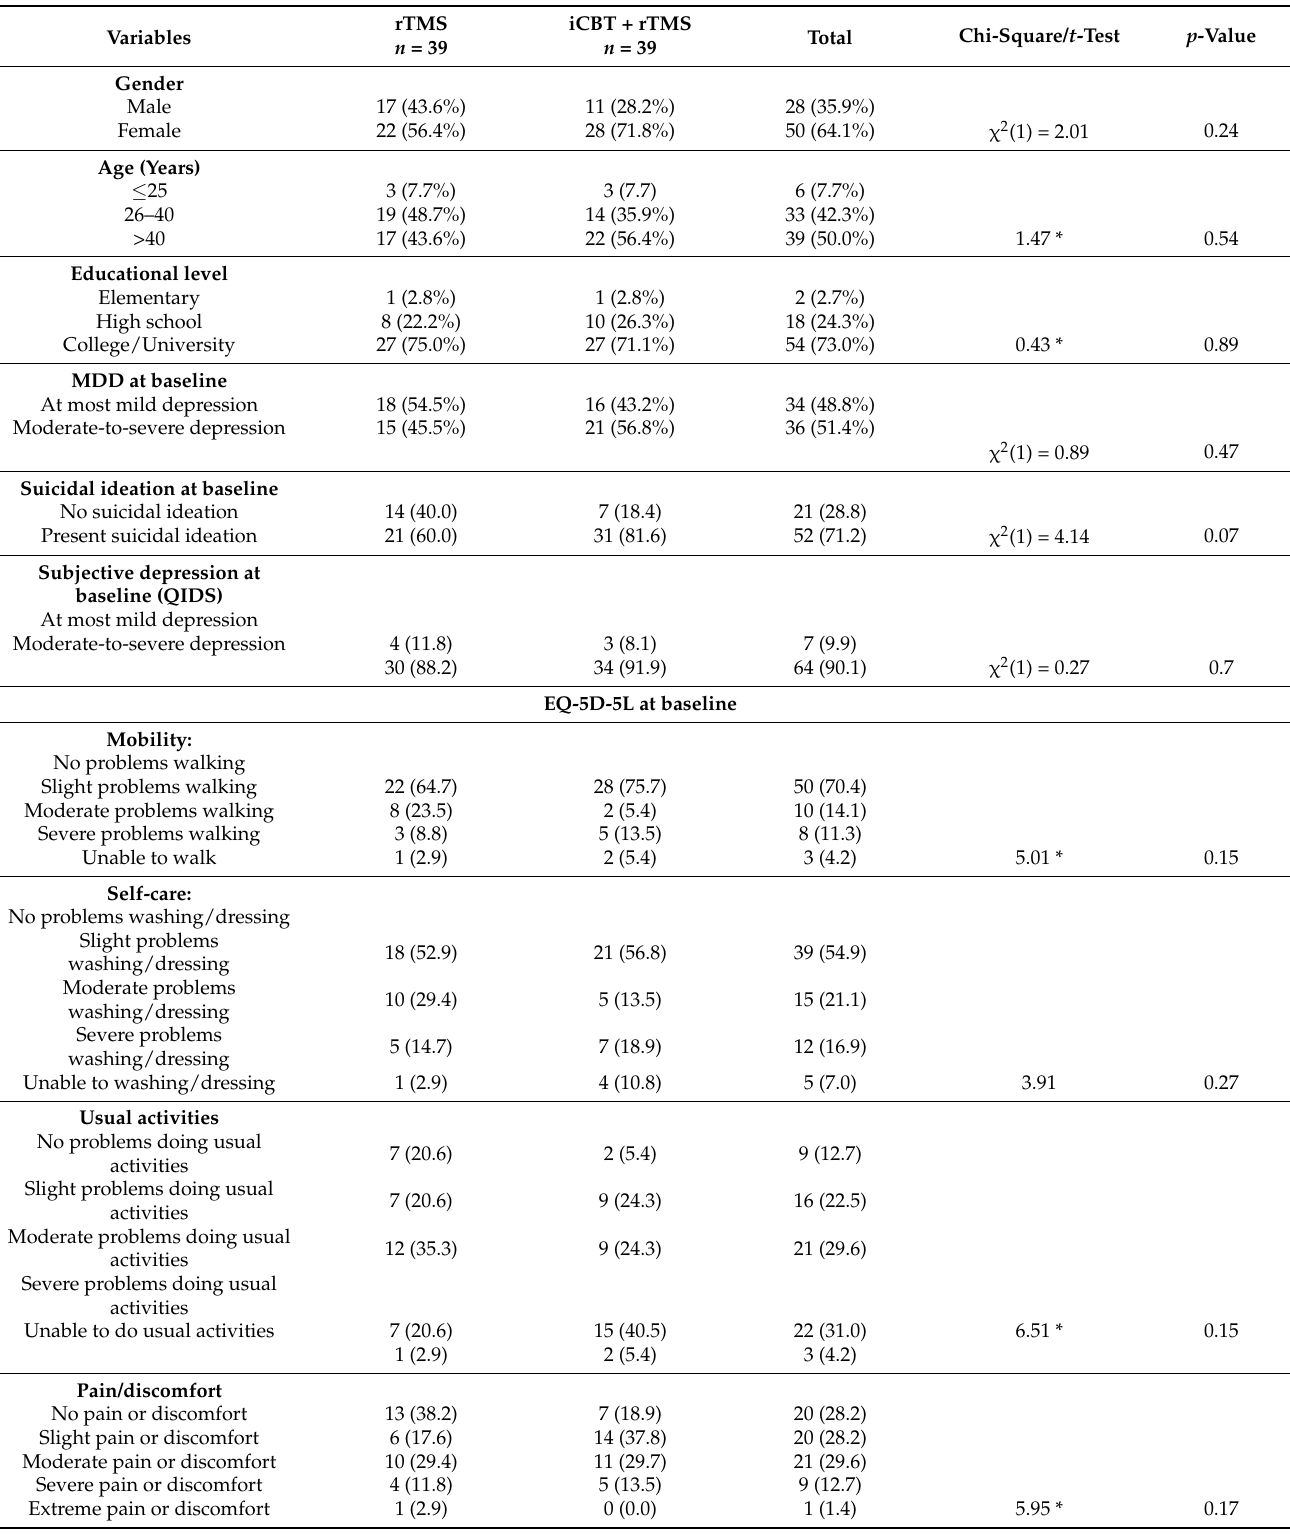
Table 1. Baseline distribution of sociodemographic and clinical characteristics between the two study groups at